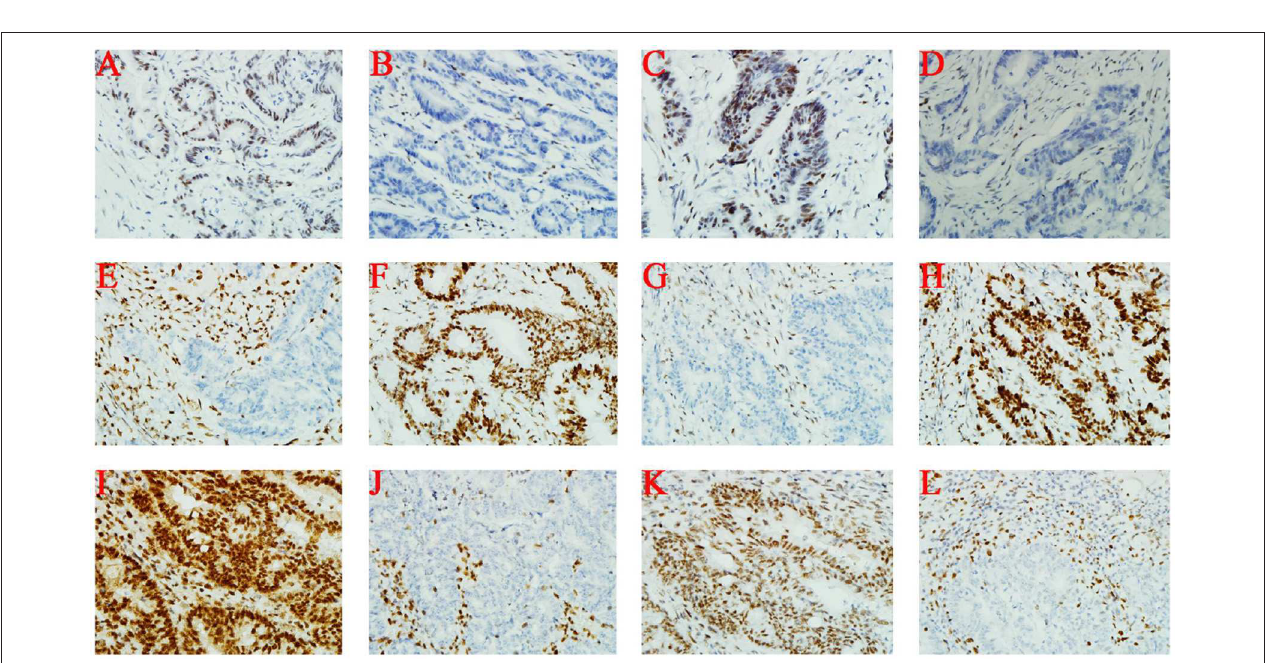
FIGURE 2 | Immunohistochemistry. (A–D) III-1; (E–H) II-1; (I–L) II-2. From left to right, the antibodies in each column were specific for MLH1, MSH2, PMS2, and MSH6. Analysis of the Mutant Proteins The MSH2 c.1661 + 2T > G mutation produced 2 truncated proteins of 505 and 528 amino acid residues. Based